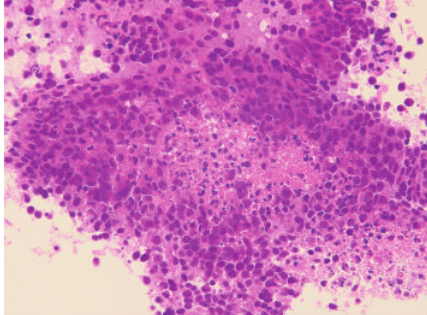
Figure 6: Representative histological image showing sheets of undifferentiated malignant cells with focal necrosis.